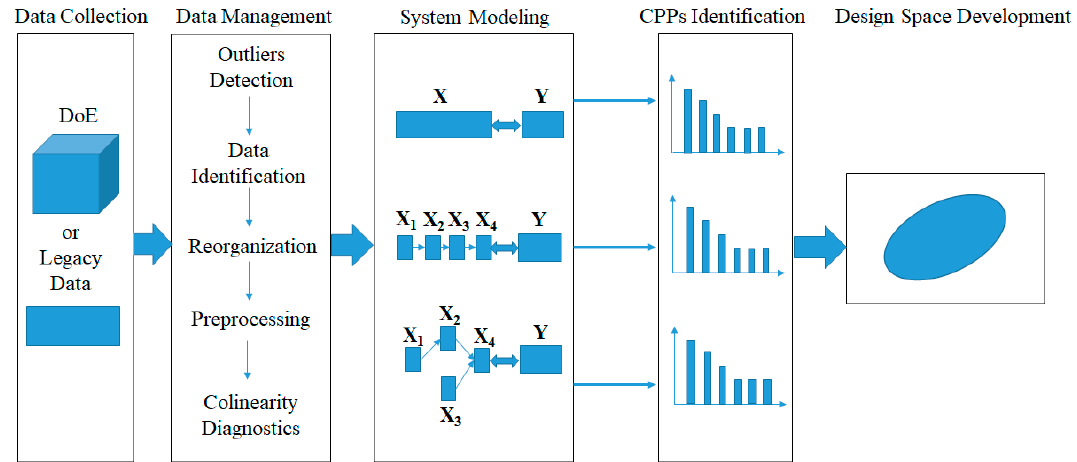
Figure 2. A novel framework to develop the design space across multi-unit operation pharmaceutical processes. DoE refers to design of